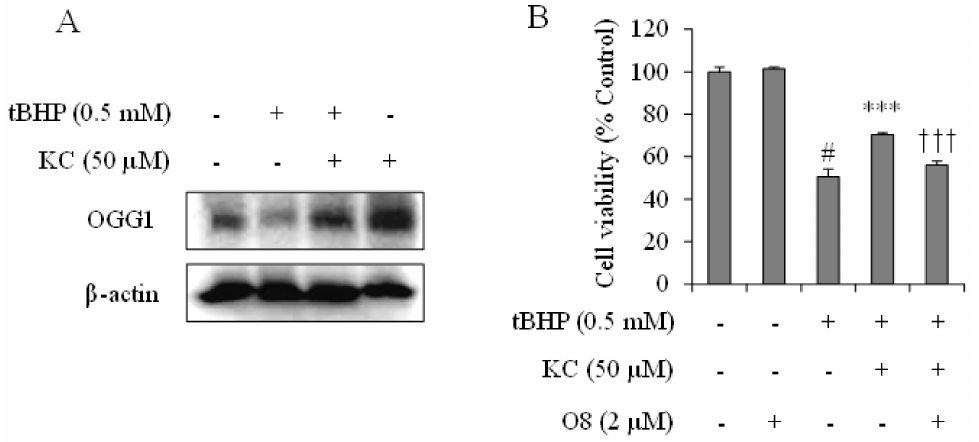
Figure 3. Effect of kushenol C on OGG1 expressions in tBHP-treated HEPG2 cells. ( A ) Cells were preincubated with or without KC for 1 h and then treated with or without 0.5 mM of tBHP for 12 h. OGG1 expressions protein levels were investigated by Western blot assay. ( B ) Cells were preincubated with KC at different concentrations and O8 (the OGG1 inhibitor) for 1 h and then treated with tBHP for 12 h. Cell viability was determined using EZ-Cytox reagent. Error bars represent the mean ± SD, # p < 0.001 vs. Control, *** p < 0.001 vs. tBHP-only treated cells, ††† p < 0.001 vs. tBHP plus KC treated